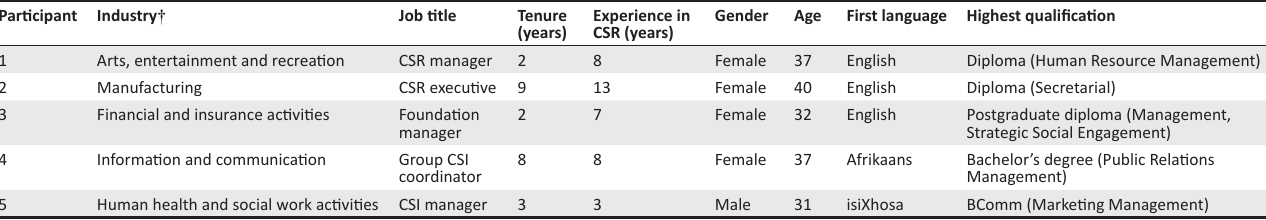
TABLE 2: Demographic profile of research participants: Phase